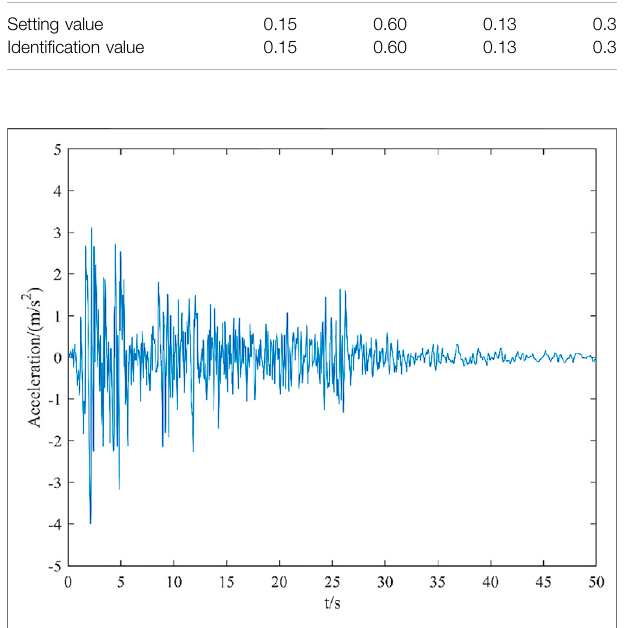
TABLE 4 | Identi fi cation values and setting values of unit damage degrees of simply supported beam. Damage Unit Number